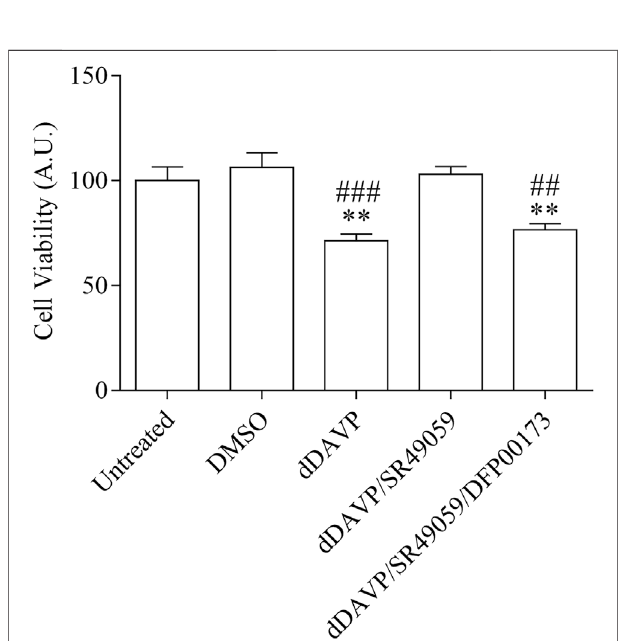
FIGURE 9 | Effect of AQP3 on glycerol permeability. Cells were grown, treated, and then labeled with calcein as described in the Methods section. The histogram shows that treatment with 2.5 µM DFP00173 for 48 h prevented the SR49059 action on dDAVP stimulation. Data are presented as means ± S.E.M. of 3 independent experiments and analyzed by one-way ANOVA followed by Dunnett ’ s Multiple Comparison test (**** p < 0.0001 vs. Untreated; #### p < 0.0001 vs. DMSO).